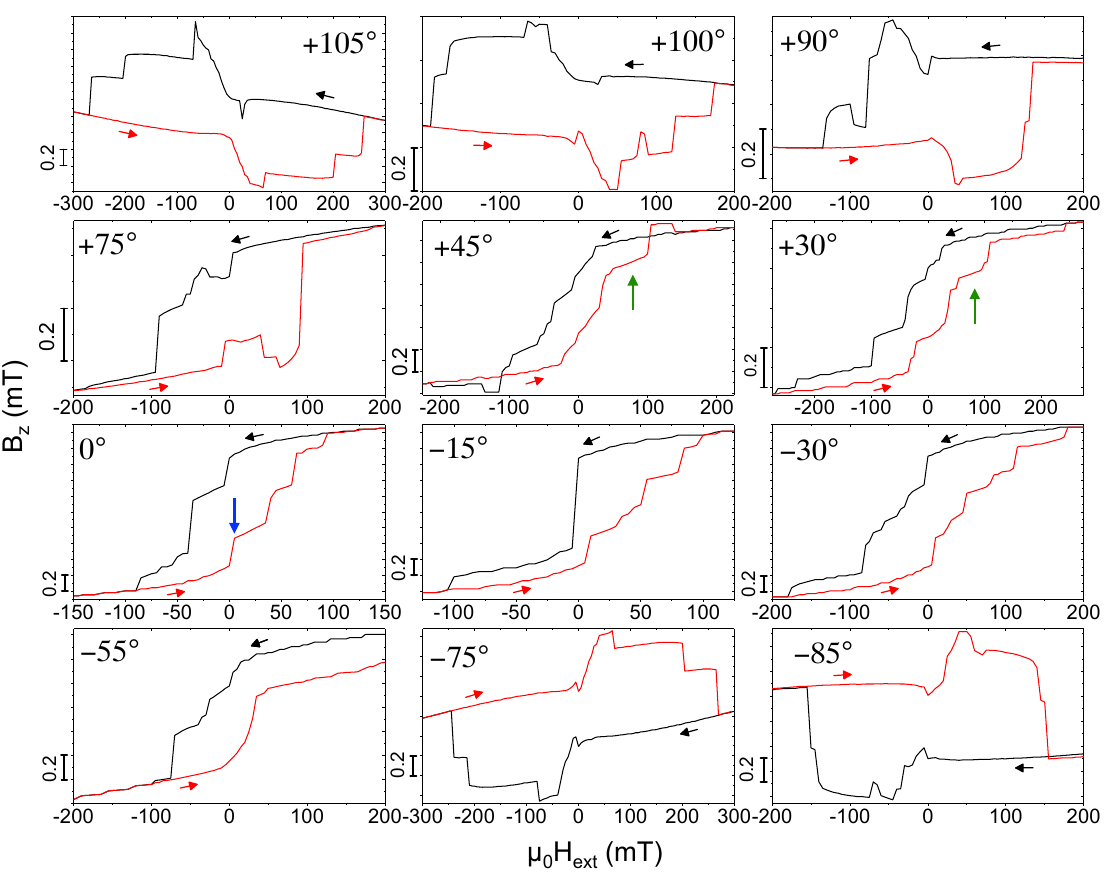
B z (cid:104) (cid:105)